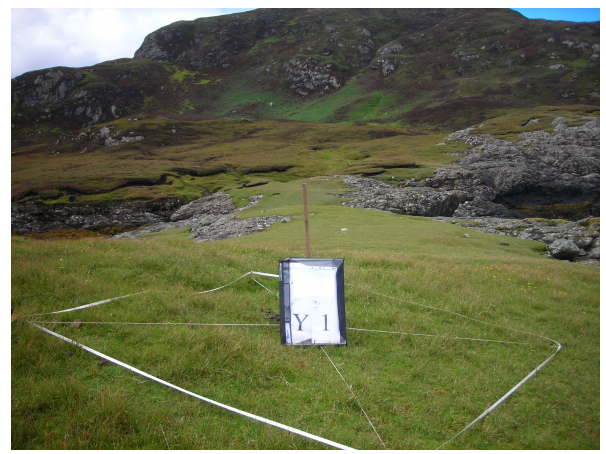
Figure 6. Example of a plot